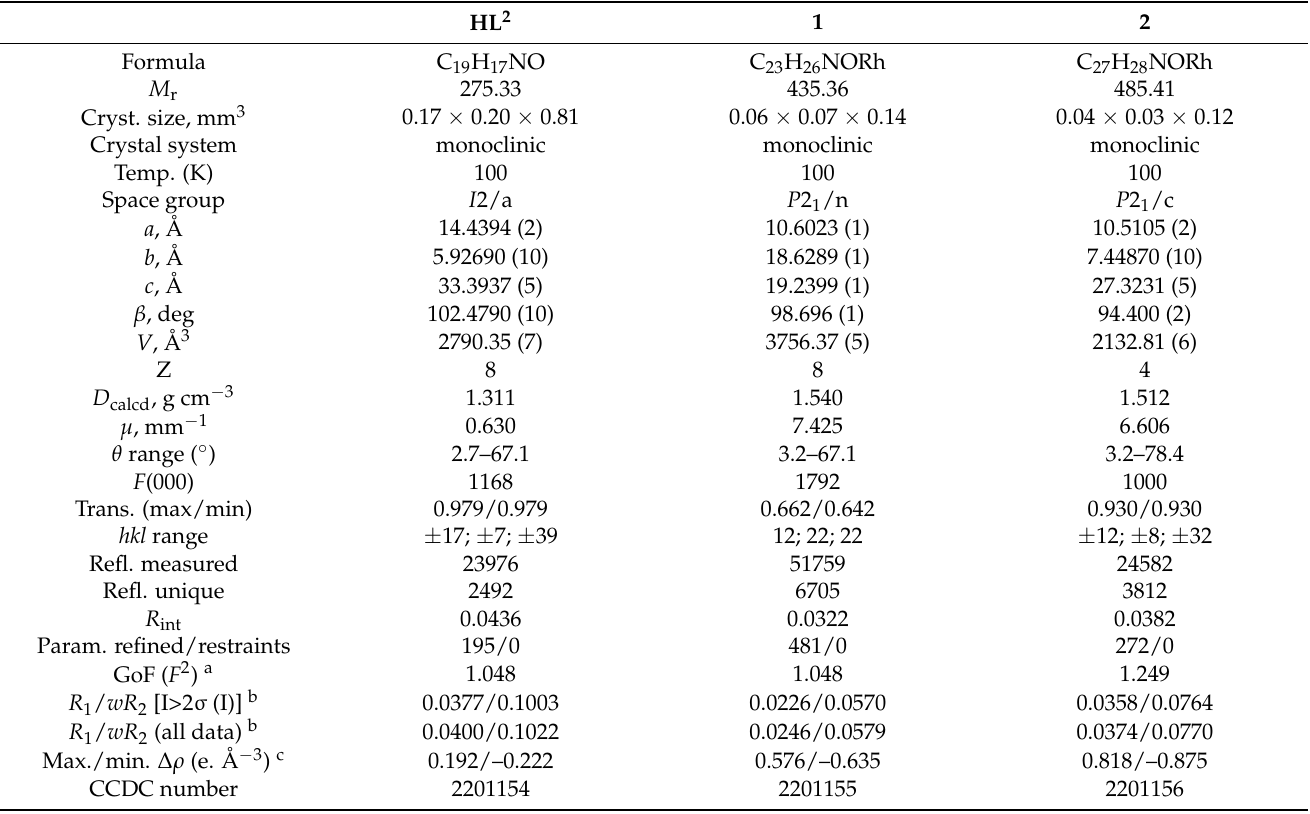
Table 5. Crystal data and structure refinement for HL 2 , 1 and 2